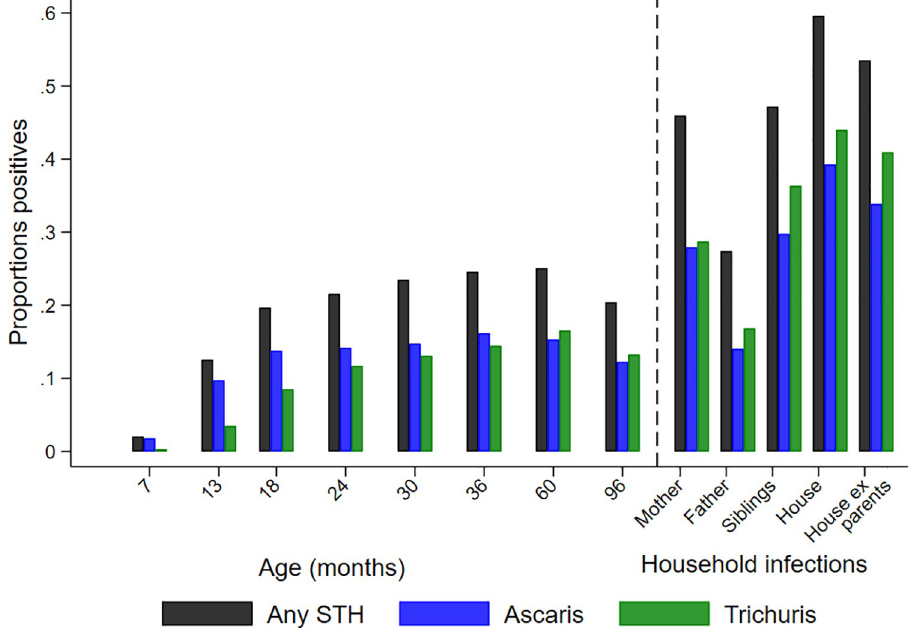
Fig 2. Prevalence of soil-transmitted helminth (STH) infections observed in children sampled at each age and among the child’s mother, father, siblings, any household member (house), and any household member excluding (ex) parents. Bars represent any STH infection (black), A . lumbricoides (blue), and T . trichiura (green). Samples for cohort are shown in Fig 1 and for mothers (2,390), fathers (997), and households (1,971), siblings (1,051) and households except parents